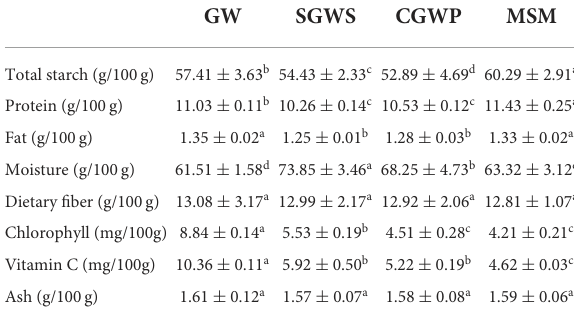
TABLE 3 Base nutrition composition of nain zhuan from different processing